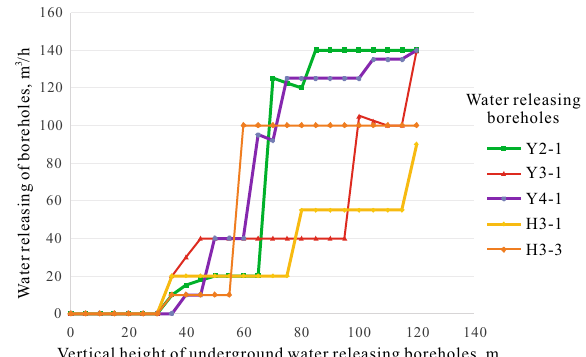
Figure 6. Water releasing results of underground boreholes in the first working face.